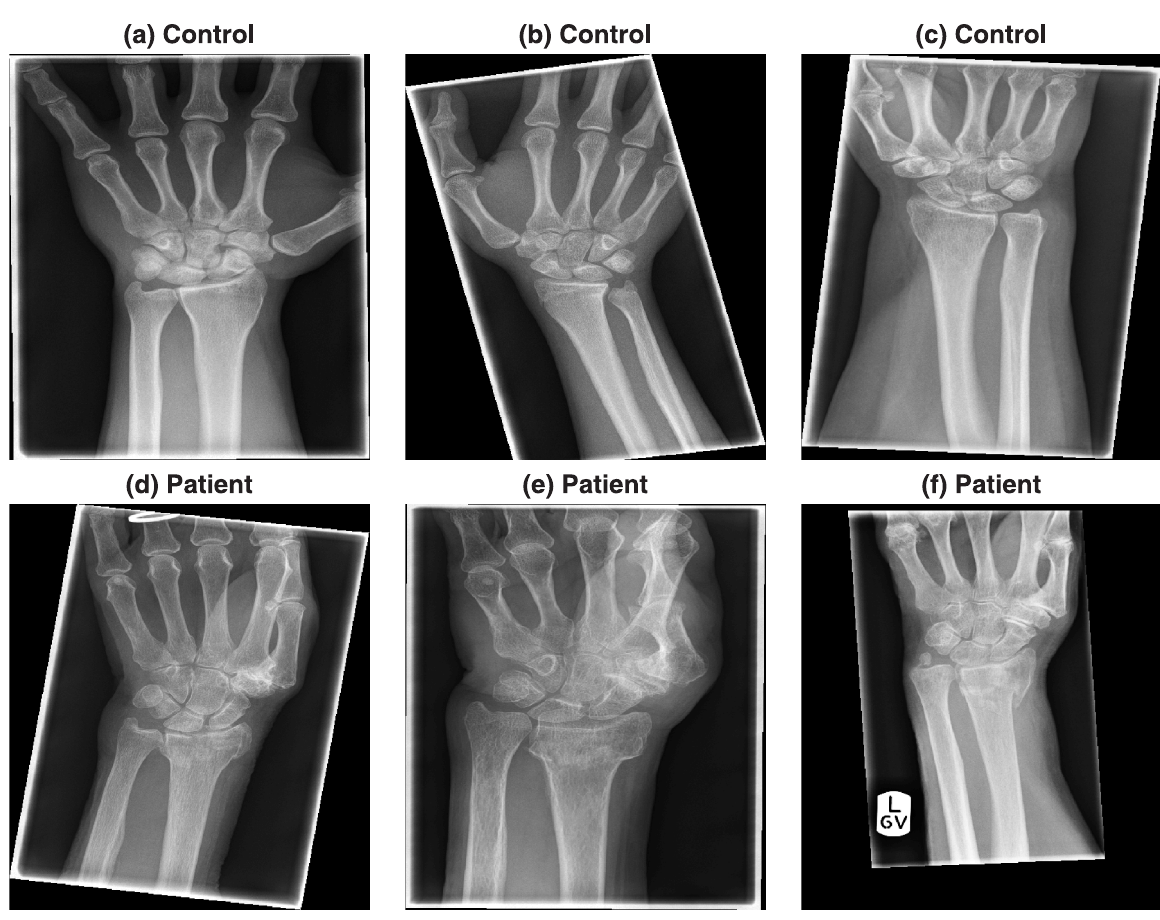
Fig 4. Pre-processing steps. (a) Original image, notice the lines of the collimator and the rotation of the radiograph. (b) Region of the bones of the forearm. (c) Edges of regions where regions show high change of intensity, detected with Canny algorithm. (d) Strongest lines detected by Hough transform overlaid on the edges. (e) Original image rotated by the angle of the lines detected in (d). (f) Region outside the collimator labelled in white. This region will be dilated to remove the lines of the collimator.